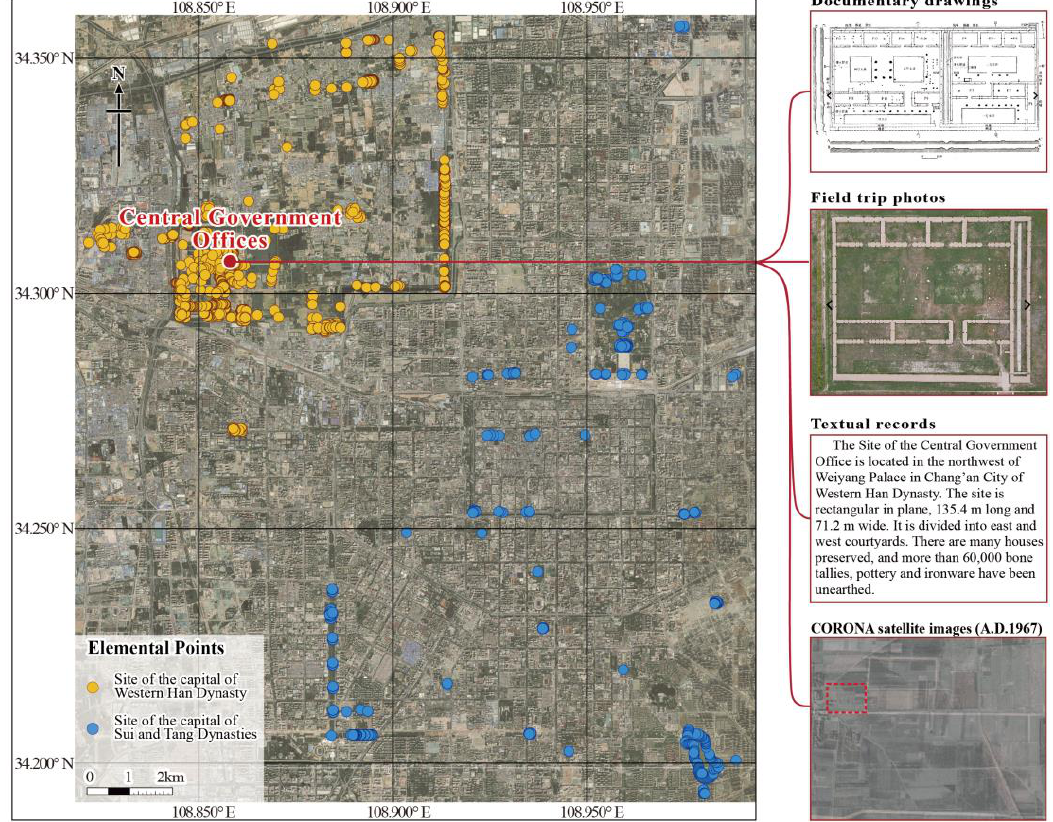
Figure 3. Distribution map of archaeological sites (including site information such as spatial coordinates, investigation photos, literature drawings, and textual records) in the capitals of the Western Han dynasty as well as the Sui and Tang dynasties.